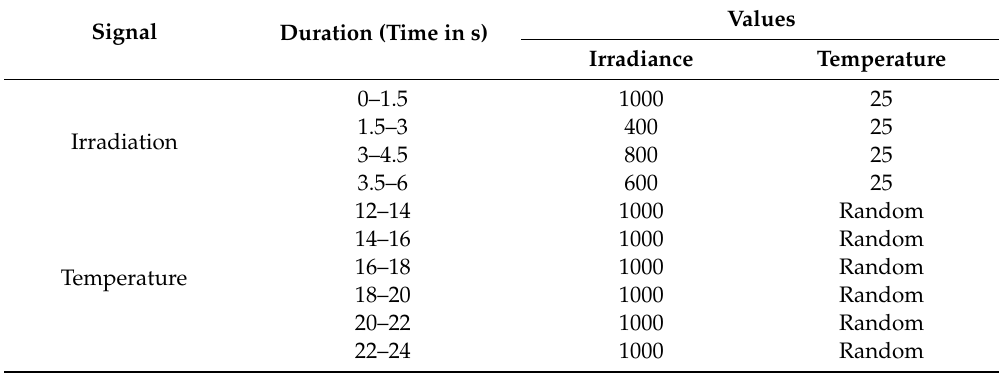
Table 6. Test pattern signals.